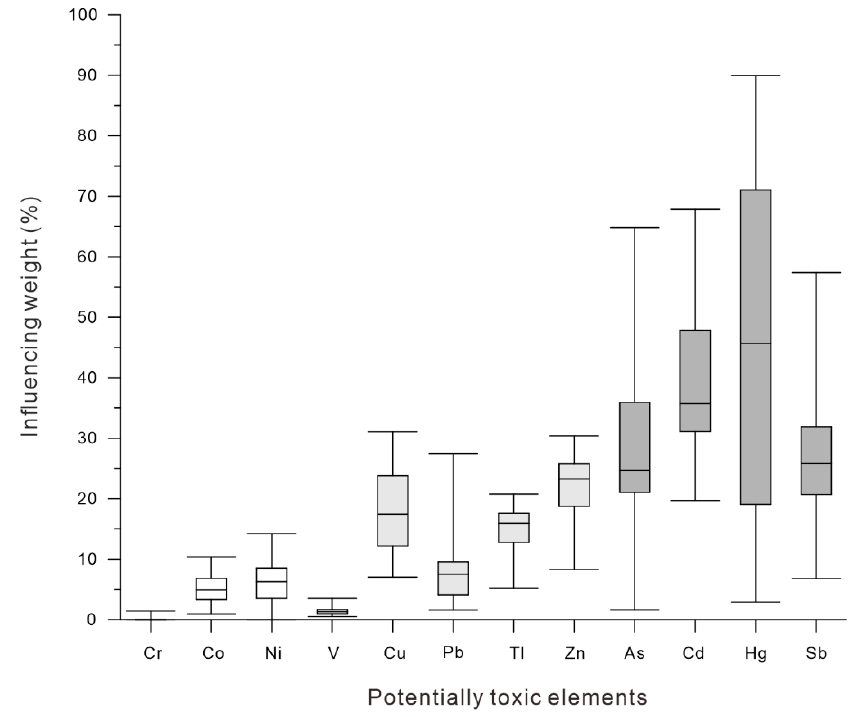
Figure 5. Statistical plots indicating the percentage of the potentially toxic elements (Cr, Co, Ni, V, Cu, Pb, Tl, Zn, As, Cd, Hg, and Sb) affected by soil organic matter, which show the minimum, maximum, median, lower quartile, and upper quartile values. Table 3. Human health risk assessment for potentially toxic elements (PTEs) in the surface soils of the Bosten Lake